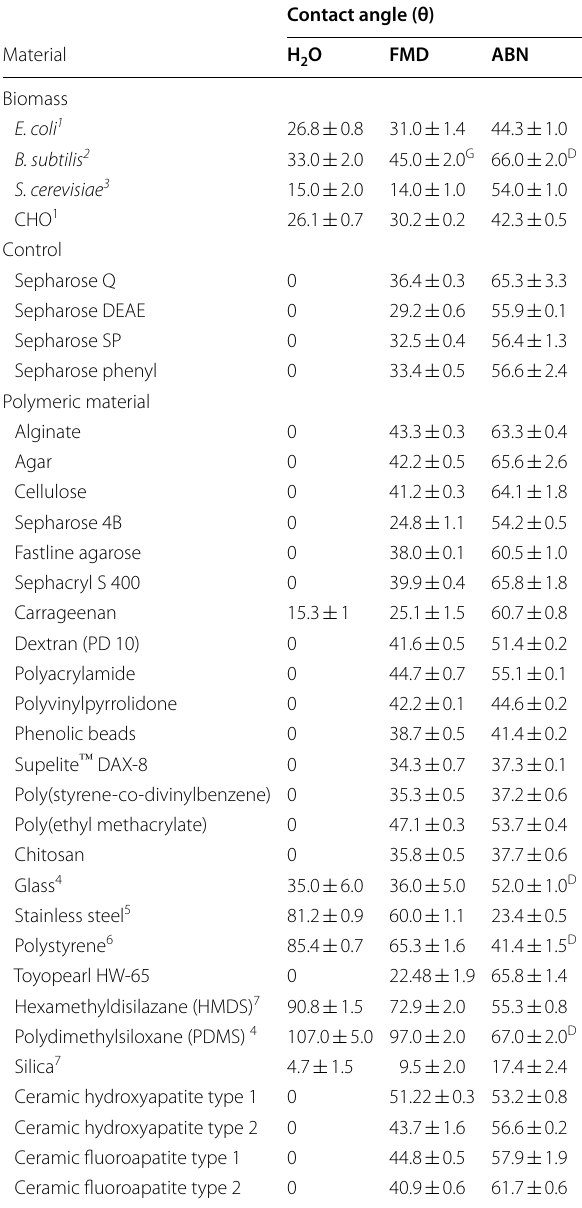
Table 2 Contact angles of for biomass, control adsorbents and polymeric